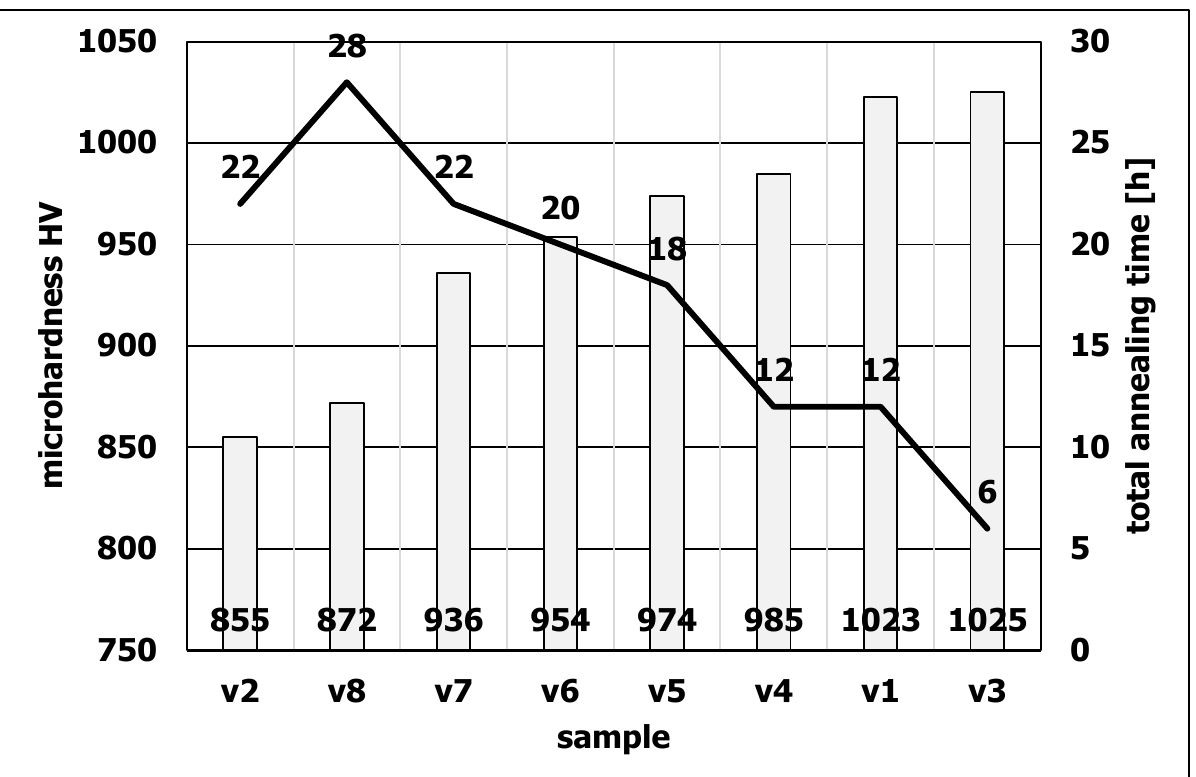
Figure 10. Microhardness of samples with a marked annealing time line for individual heat treatment variants.